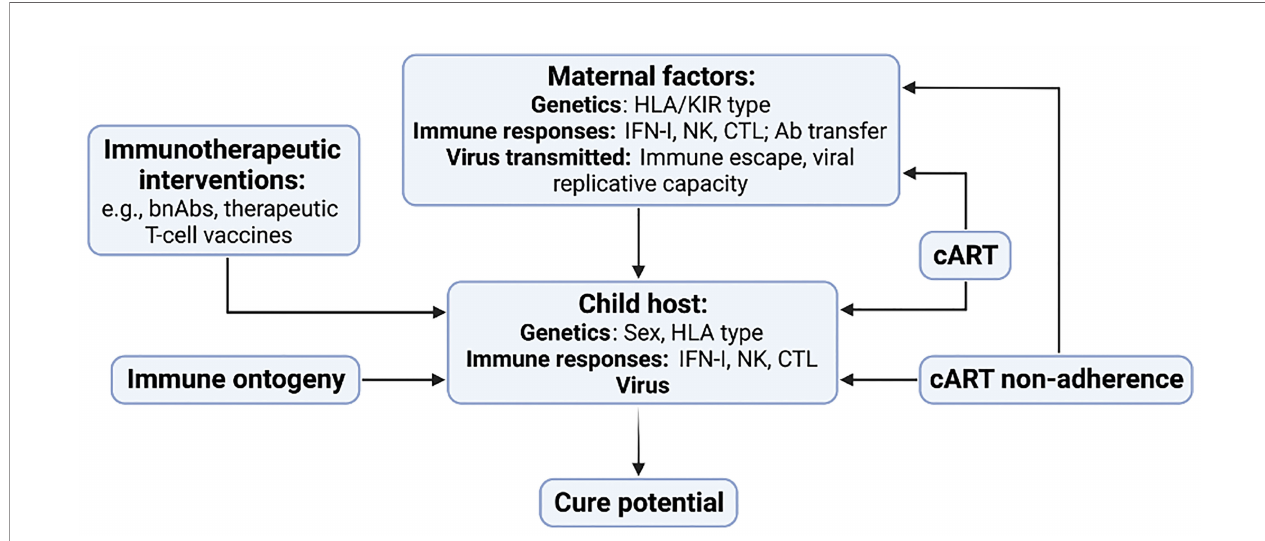
FIGURE 4 | Key factors contributing to HIV cure potential in children with HIV. Maternal factors include host genetics, immune responses and the virus that is transmitted to the child. Factors in the child include genetic factors such as sex and HLA type, the innate and adaptive immune response, and the nature of the virus that was transmitted. cART has strong in fl uences on the immunogenetics of transmitting mother-child pairs in addition to its early initiation following MTCT resulting in a small and low-diversity reservoir in many children. Changes in the child ’ s immune response resulting from immune ontogeny, in particular the increasing antiviral ef fi cacy of the HIV-speci fi c CTL response with increasing age, will affect the impact of immunotherapeutic interventions such as bnAb therapy and T-cell